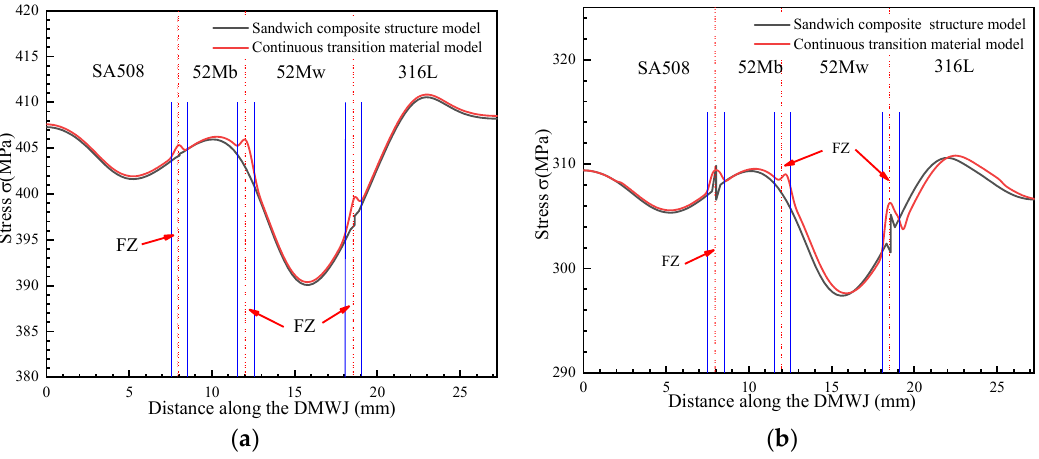
Figure 10. Y -directional stress under ( a ) an axial load and ( b ) an axial load and internal pipe pressure. As shown in Figure 11, under an axial load, the sandwich structure model showed a significant increase in stress at the SA508/52M and 52M/316L interfaces. For an internal pressure loading, the opposite trend was observed and a sudden change in stress occurred at the interface region. The continuous transition model eliminated abrupt changes in stress, allowing for a continuous transition in the mechanical properties of the materials in the interface regions.